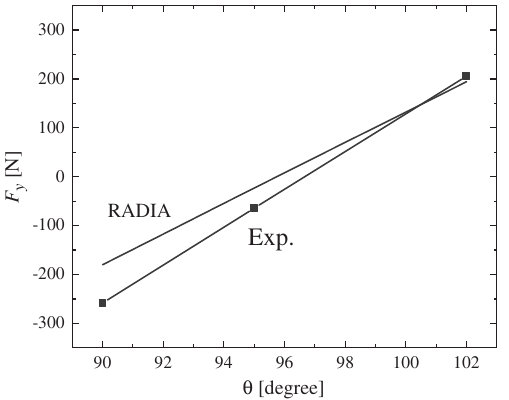
FIG. 11. Results of the force measurement, in comparison with the numerical